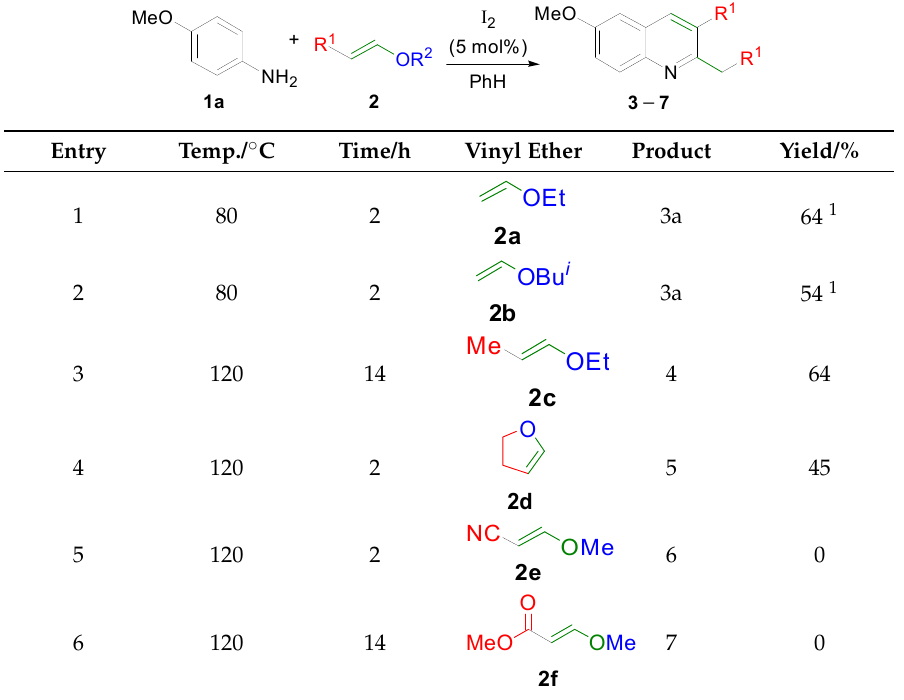
Table 3. Modification of the pyridine ring of quinoline 3